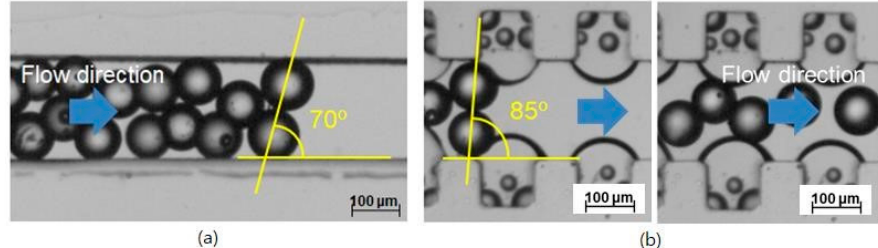
Figure 2. Prevention of microsphere blockage in the catheter channel by convex air bubbles; ( a ) Occurrence of the blockage arching at an arching angle of 70 ◦ in the straight catheter channel without the convex air bubbles, ( b ) Free movement of the microspheres at a geometrical arching angle of over 85 ◦ in the straight catheter channel with the convex air bubbles.